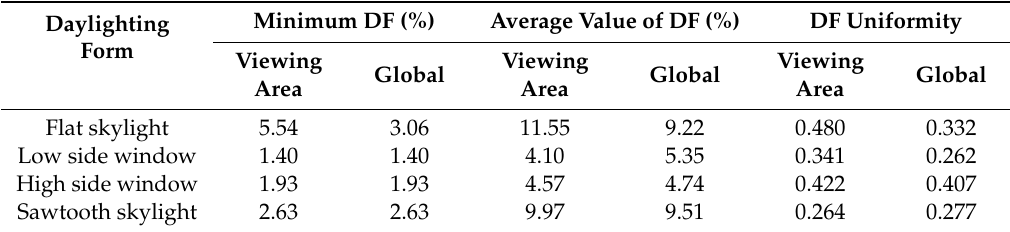
Table 3. Average DF s and uniformity values of di ff erent types of daylighting window.